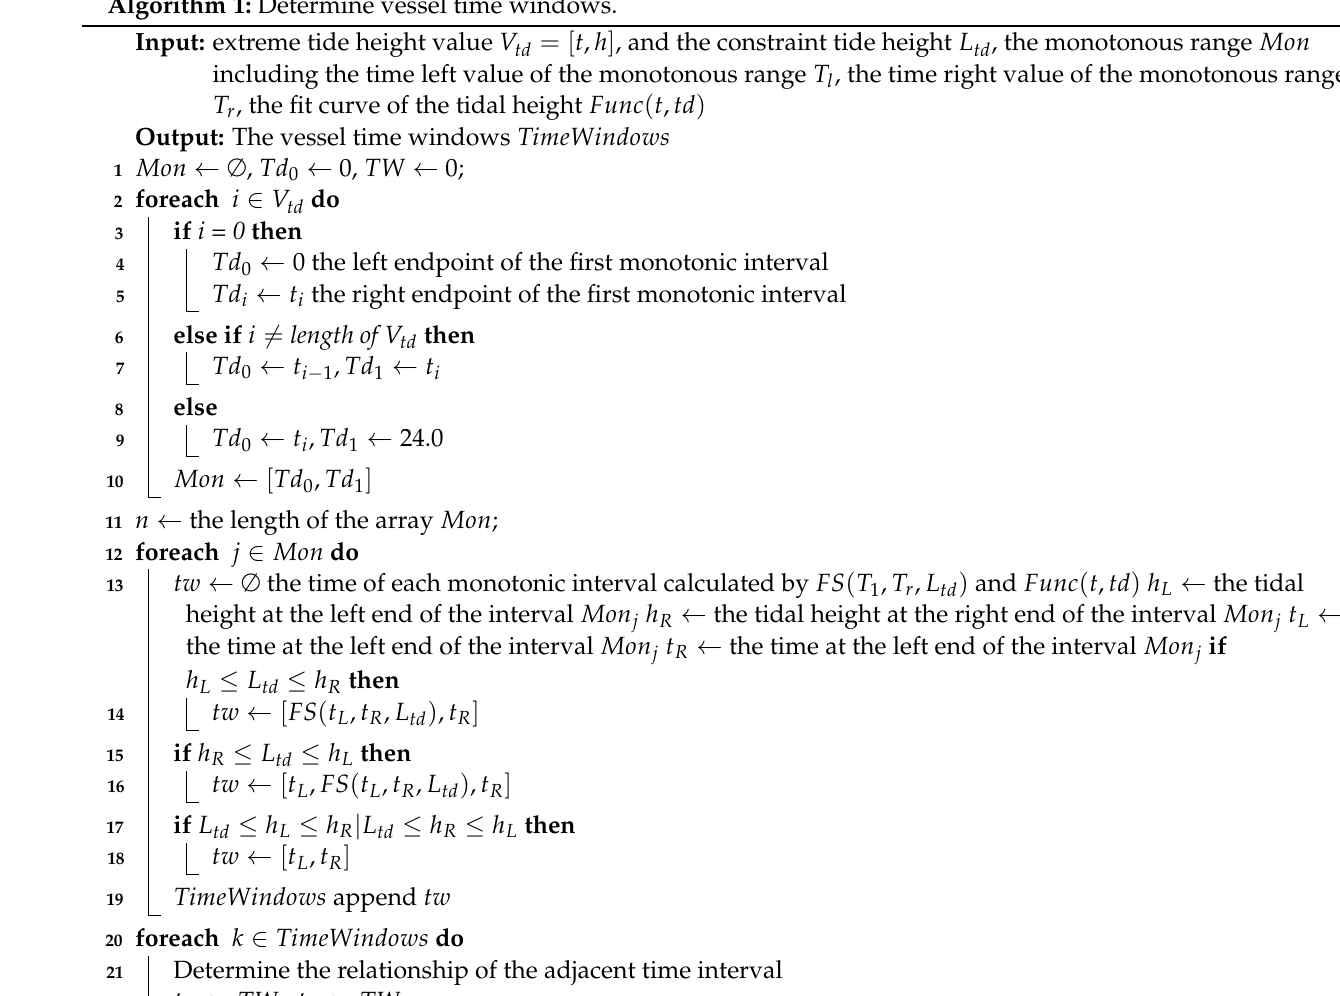
Algorithm 1: Determine vessel time